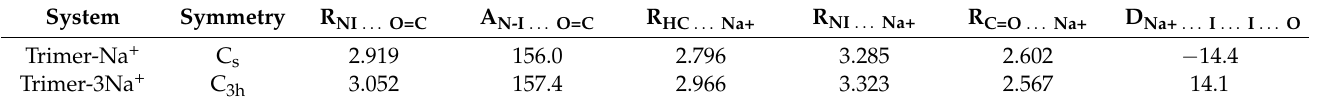
Figure 8. Optimized geometry of the Trimer-Na + complex ( top ) and the Trimer-3Na + complex ( bottom ). Intramolecular OH . . . N hydrogen bonding interactions and intermolecular HC . . . Na + and NI . . . O=C interactions are indicated with respective dashed lines. Individual atoms can be distinguished by color: C (grey), H (white), N (blue), O (red), and I (purple). Table 5. Relevant geometrical parameters for Na + binding by the cyclic trimer of the model system,